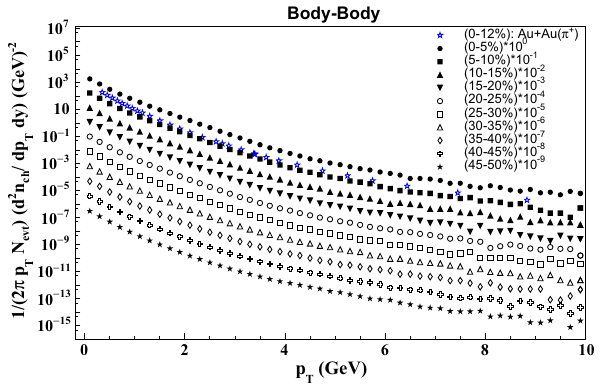
Fig. 17 Normalized transverse momentum distribution of charged hadrons in body–body configuration for various centrality classes